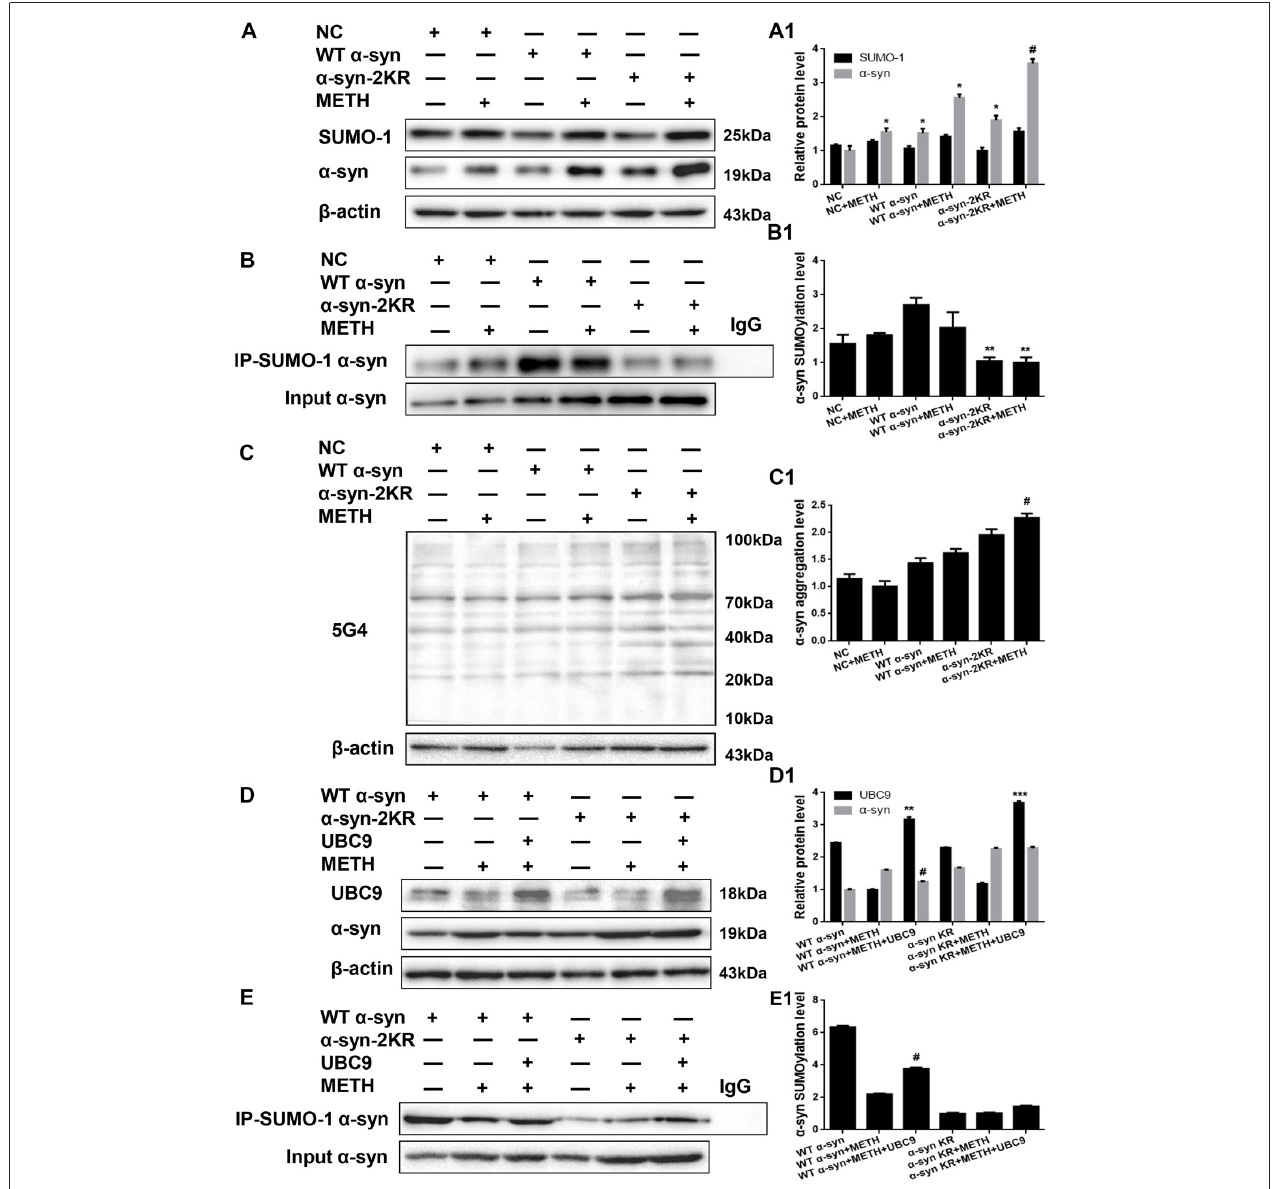
FIGURE 6 | Impaired SUMOylation of α -syn accelerates α -syn aggregation induced by METH in SH-SY5Y cells. SH-SY5Y cells stably expressing GFP, WT α -syn or α -syn-2KR were treated with or without 2.0 mM METH for 24 h. (A–C,A1–C1) In addition, UBC9 was overexpressed in SH-SY5Y cells stably expressing WT α -syn and α -syn-2KR (D,E,D1,E1) . Western blot (A–E) and quantitative analyses (A1–E1) were performed to evaluate the efficiency of α -syn expression, and the expression of SUMO-1 and UBC9, and the expression, aggregation and SUMOylation of α -syn. β -Actin was used as a loading control. ∗ p < 0.05 compared with the LV-GFP group. ∗∗ p < 0.05 compared with SH-SY5Y cells stably expressing WT α -syn. ∗∗∗ p < 0.05 compared with SH-SY5Y cells stably expressing α -syn-2KR. # p < 0.05 vs. METH-treated SH-SY5Y cells stably expressing WT α -syn. The data were analyzed using one-way ANOVA followed by LSD post hoc